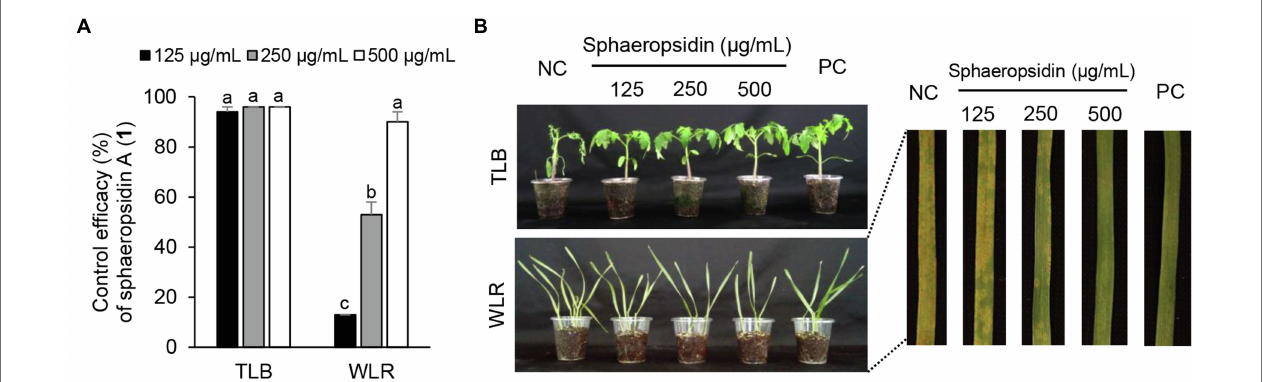
FIGURE 4 | Effects of sphaeropsidin A ( 1 ) isolated from Aspergillus candidus SFC20200425-M11 on the development of tomato late blight (TLB) and wheat leaf rust (WLR) caused by Phytophthora infestans and Puccinia triticina . (A) Control efficacy of sphaeropsidin A ( 1 ) against TLB and WLR. The bars represent the mean ± standard deviation of two runs with three replicates. Different small letters in each bar indicate a significant difference at p < 0.05 (Duncan’s multiple range test). (B) Representatives of plants treated with sphaeropsidin ( 1 ) at a concentration of 125, 250, and 500 μ g/ml. Plants were inoculated with sporangia or spores of P. infestans or P. triticina 1 day after treatment with sphaeropsidin ( 1 ). Treatment with Tween 20 solution containing 5% methanol and chemical fungicides (dimethomorph for TLB and flusilazole for WLR) were prepared as negative and positive controls (NC and PC), respectively.